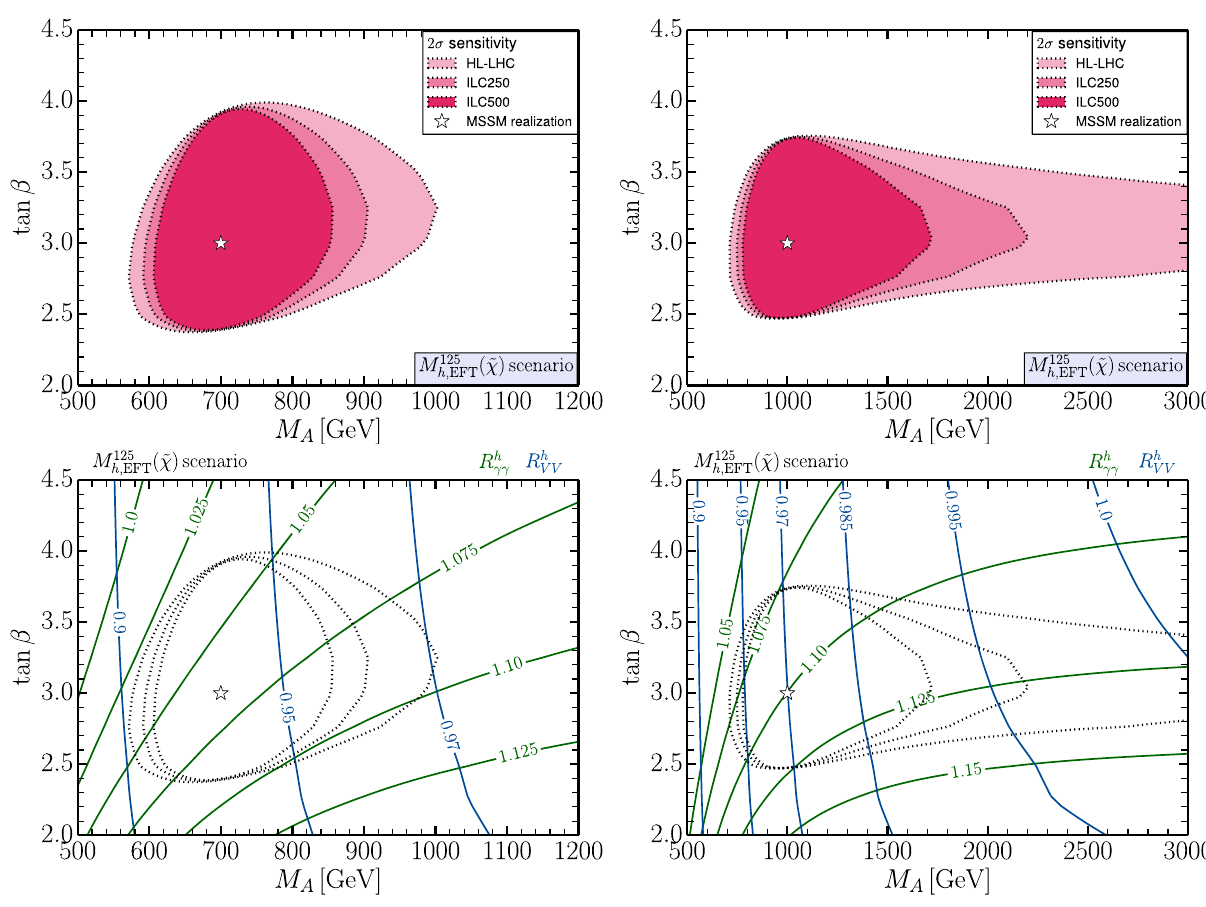
( 700GeV , 3 ) (left panel) or ( M , tan β) = ( 1TeV , 3 ) (right panel) is A realized in nature. The blue and green contours in the lower panels show the inclusive rate for pp → h → V V ( V = W ± , Z ) , R h , and VV the inclusive rate for pp → h → γγ , R h γγ , respectively, with the 2 σ parameter ranges from the upper panels